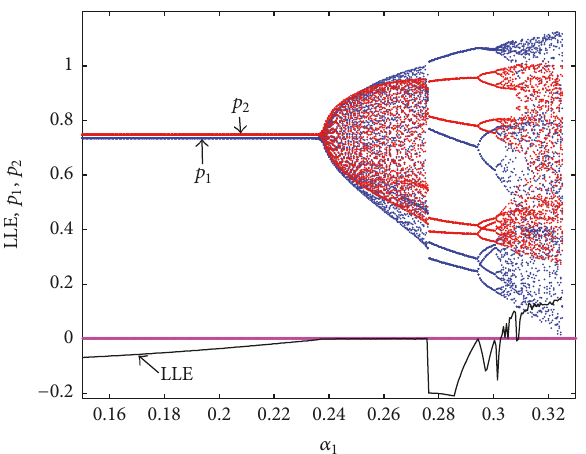
Figure 2: The bifurcation diagram of prices and LLE with respect to 𝛼 𝜃 = 0.5, 𝛼 = 0.5, 𝑤 1 when